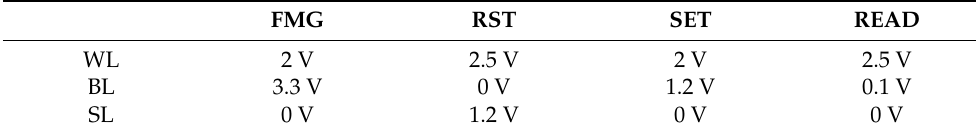
Table 1 presents the different voltage levels used during the different operating